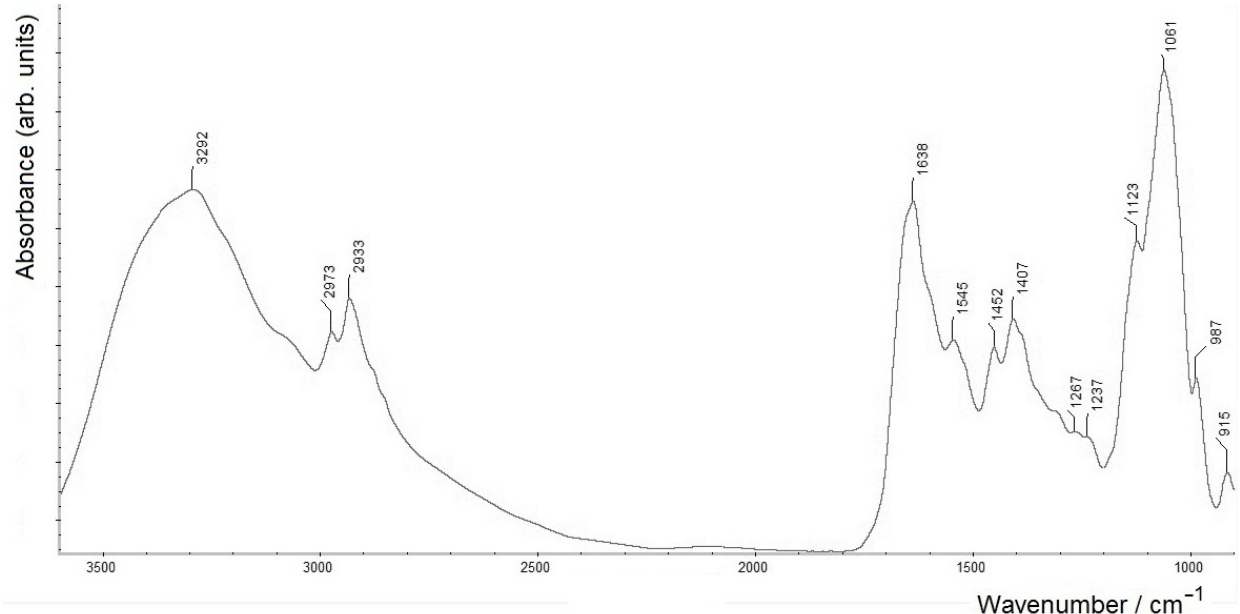
Figure 4. FTIR spectrum of the polysaccharide fraction (sample BM3) obtained from A. baldaniorum Sp245 biofilm matrix by mild acidic hydrolysis (measured in the transmission mode on a ZnSe glass disc).